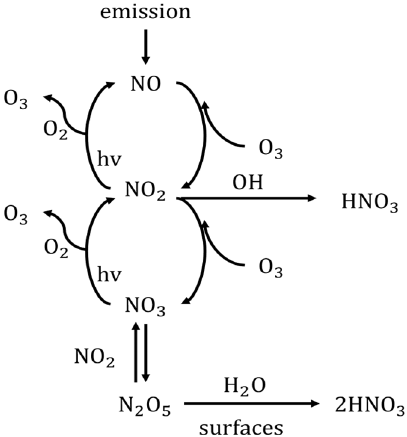
Figure 6. NO X reactions involved in the